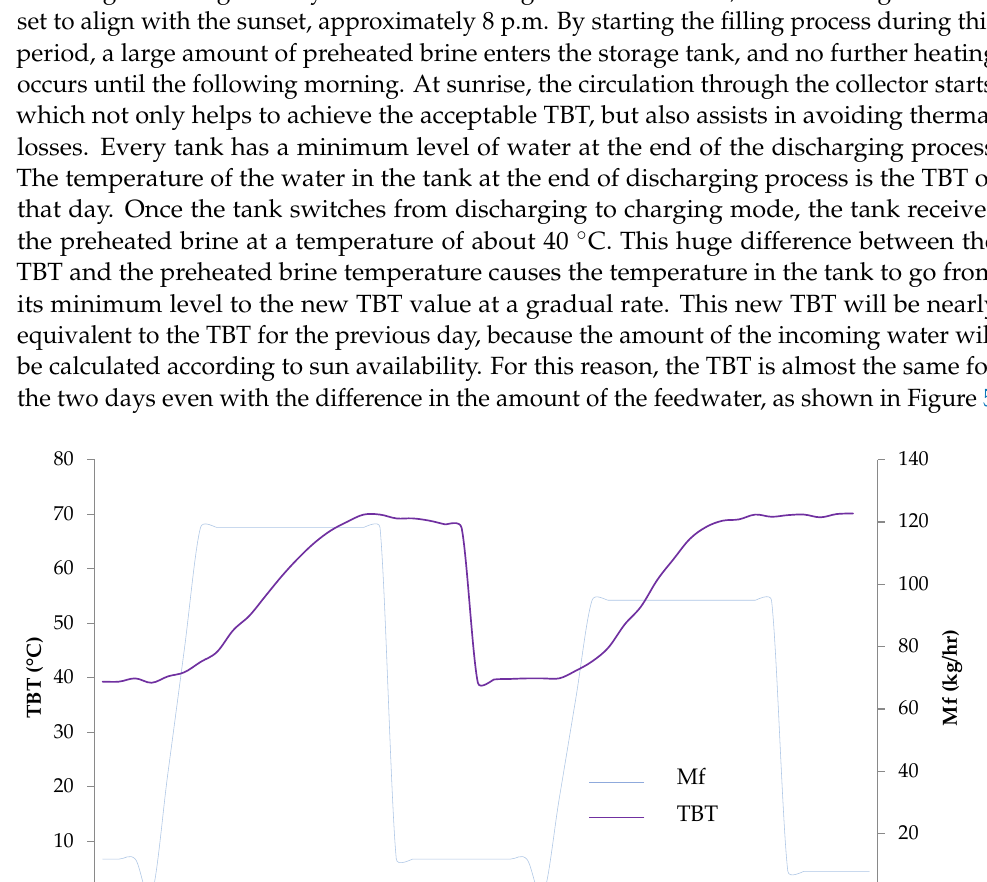
01020304050607080 Figure 5. Top brine temperature profiles and variations of feed Figure 5. Top brine temperature profiles and variations of feed water. dual tank storage system, where the MSF was separated from the variation in the solar energy during the day, resulting in a constant distillate production rate without interfer- ence from solar energy variation. Figure 6. Cumulative distillate production rate on 26 September 2020. Figure 7 serves to better visualize the daily changes in mass flow and temperature. This Figure is composed of three bar graphs: one for energies, one for temperatures, and one for mass flows over a week-long span from 23 – 30 September. The first graph shows